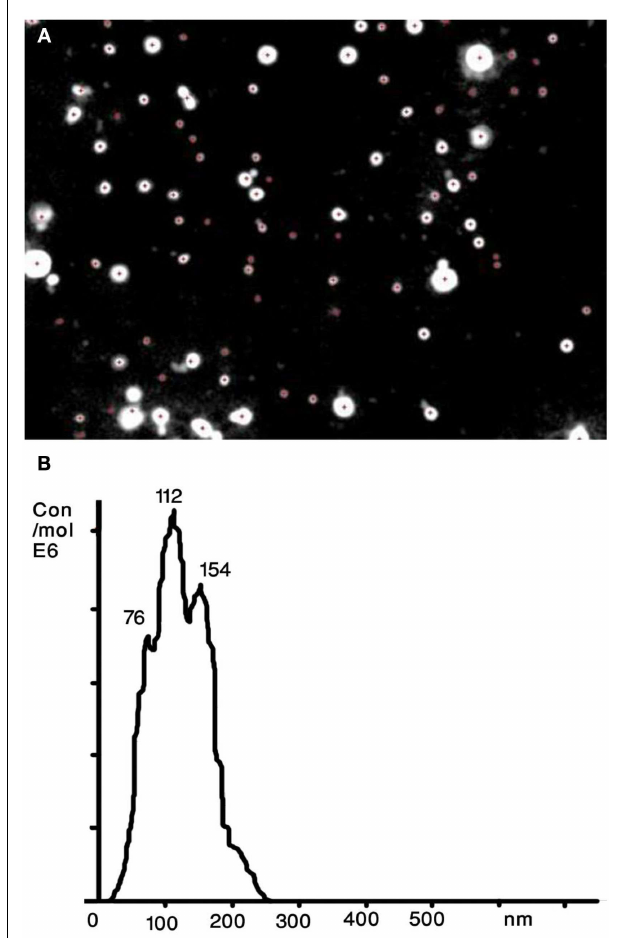
FIGURE 2 | Nanoparticle tracking analysis (NTA) of human serum derived extracellular vesicles (ECVs). (A) The image presents particles moving under Brownian motion. (B) The NTA software then rapidly generates a distribution graph on a particle-by-particle basis and a count (in terms of absolute number concentration) of the